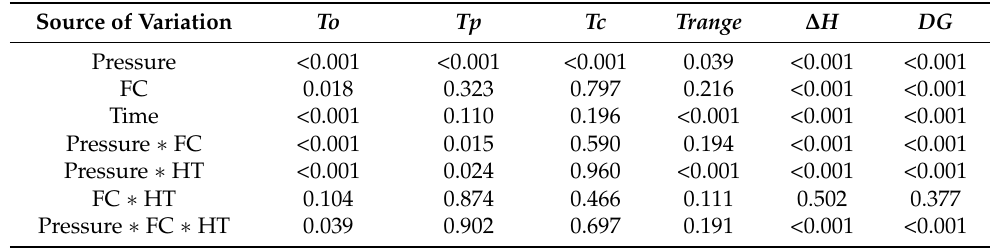
Table 2. Summary of probability values after three-way ANOVA analysis of thermal properties of cassava flour as affected by pressure, flour concentration (FC), and holding time (HT). Source of